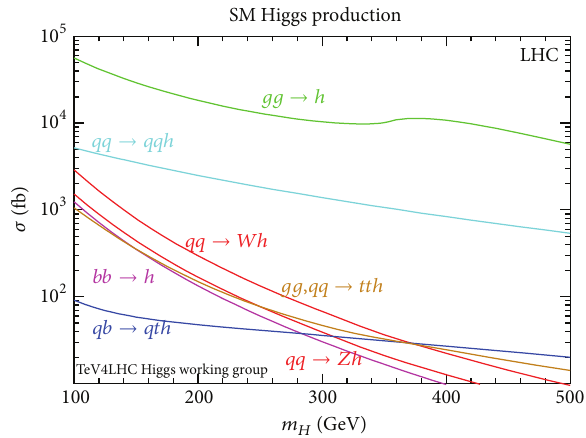
Figure 2: The cross section of the main processes of Higgs boson production in 𝑝𝑝 collisions at LHC (from [49]).